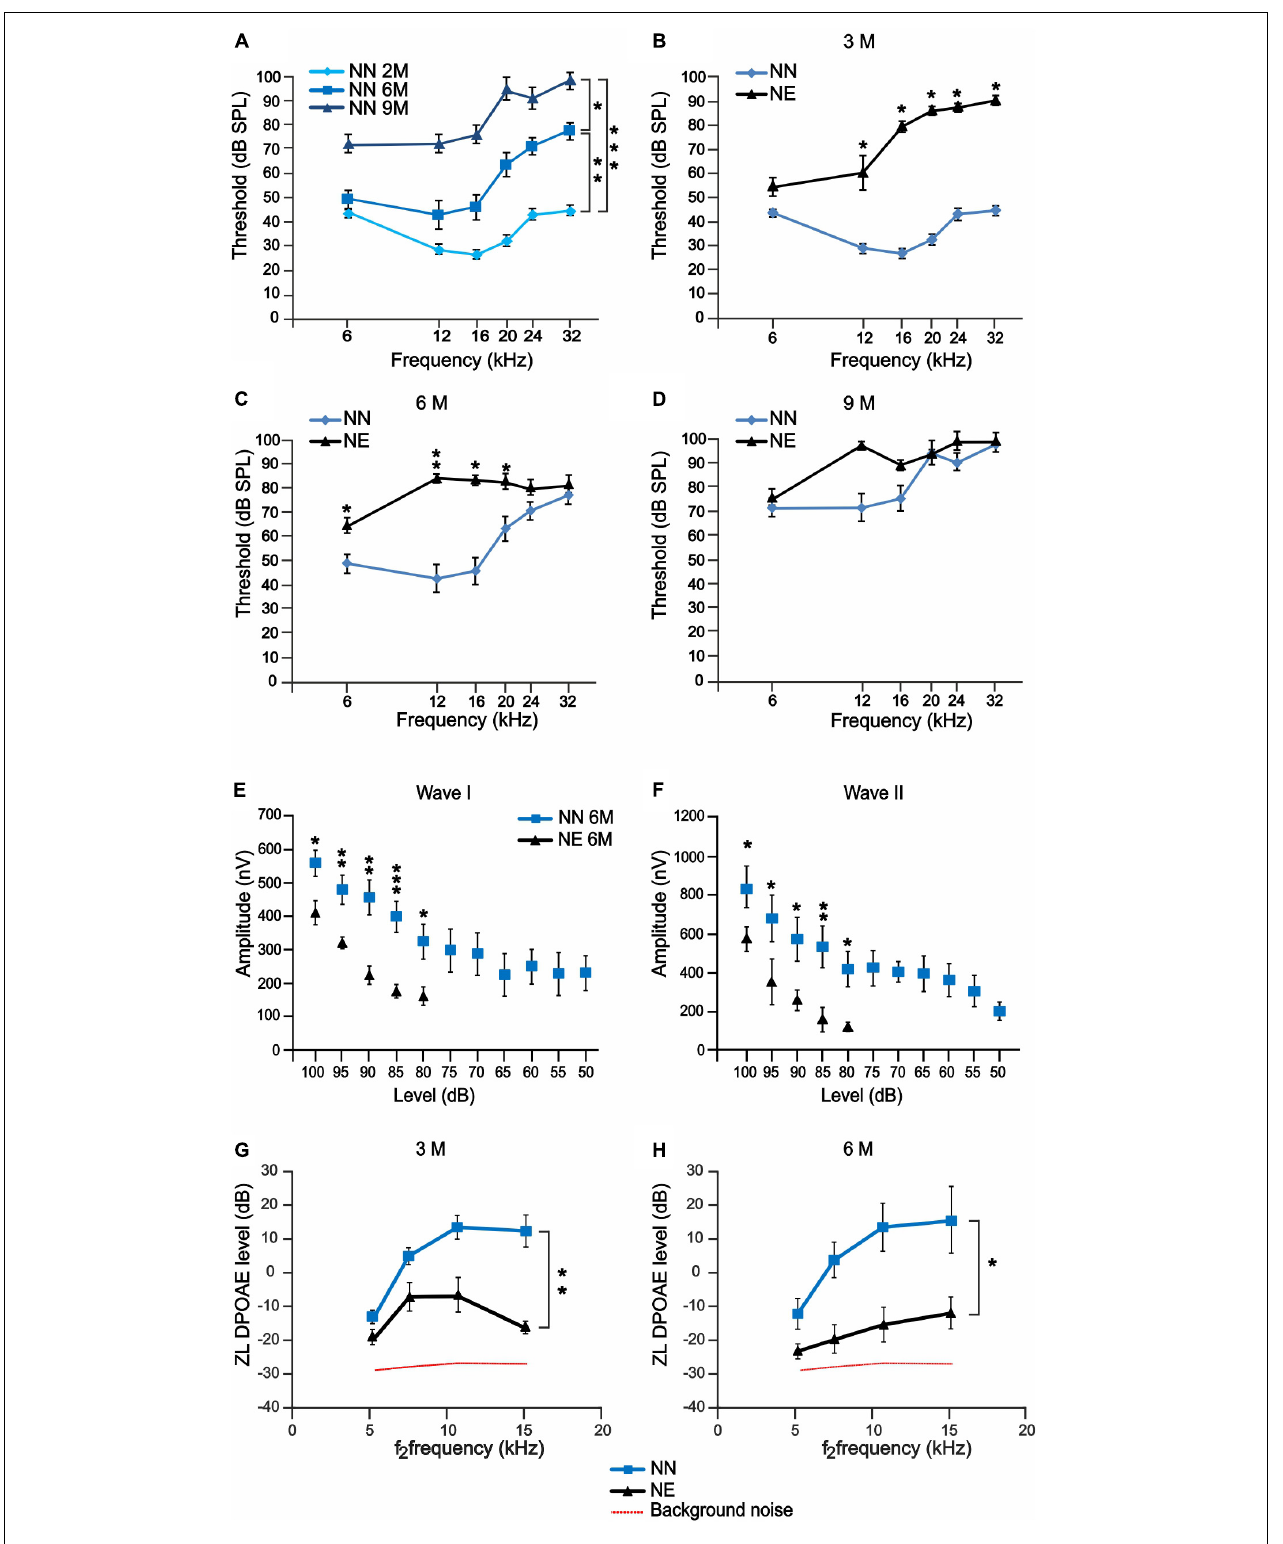
FIGURE 2 | Noise-induced hearing loss accelerates auditory dysfunctions in 6 months of age mice. (A–D) ABR recordings in no noise-exposed (NN) and/or noise-exposed (NE) C57BL/6 mice at different months of age. (A) Graph shows ABR threshold values (means ± SEM) in mice of 3, 6, and 9 months of age